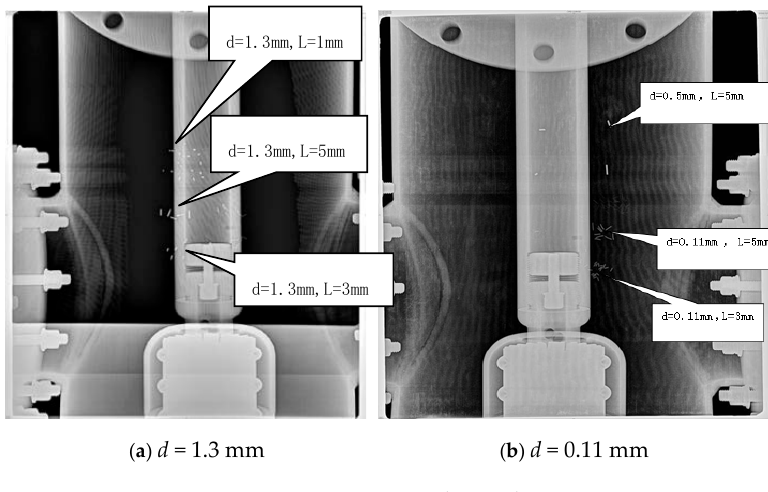
Figure 8. Free metal particle.